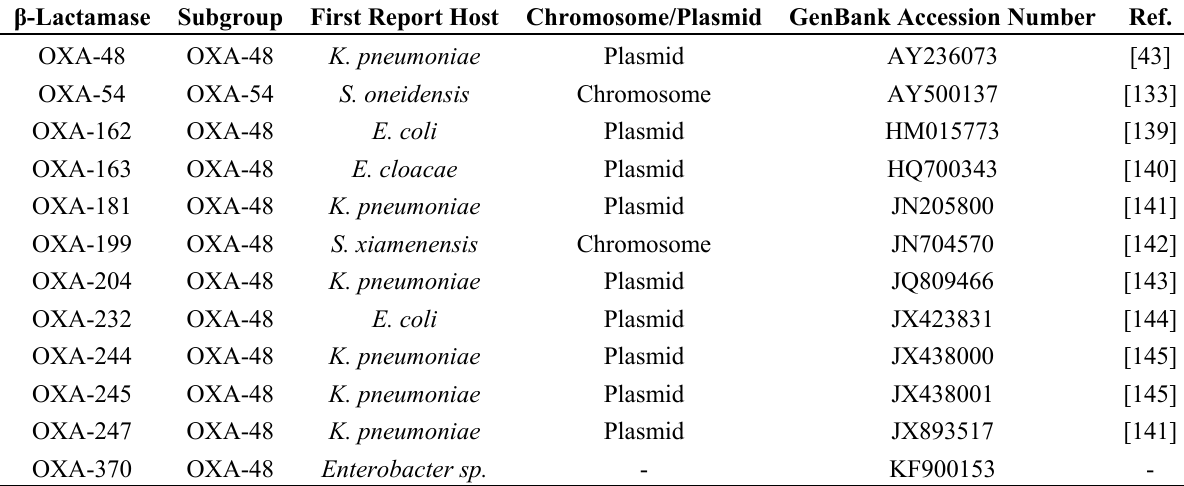
Table 12. OXA-48 like